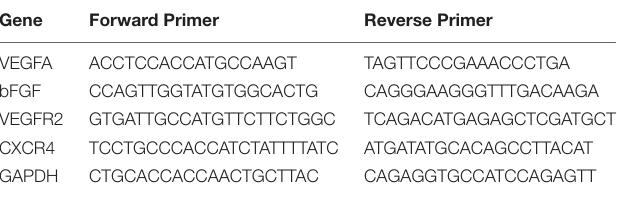
TABLE 1 | List of